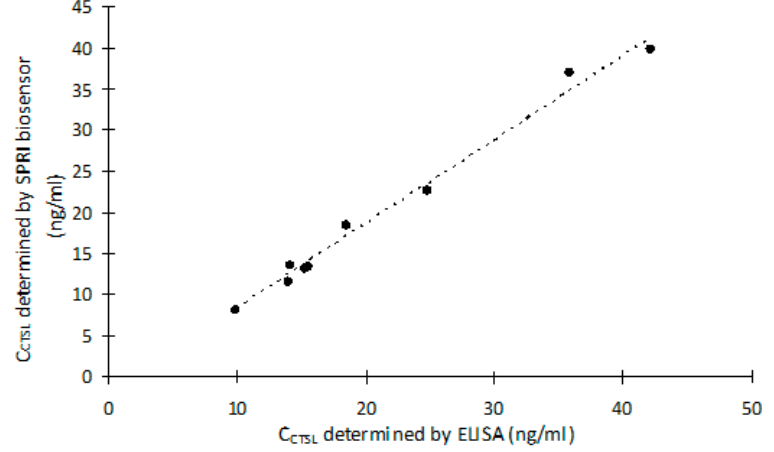
Figure 4. The linear correlation between the results of Cathepsin-L (CTSL) concentration in the control blood plasma samples obtained by Surface Plasmon Resonance Imaging (SPRI) method and ELISA.